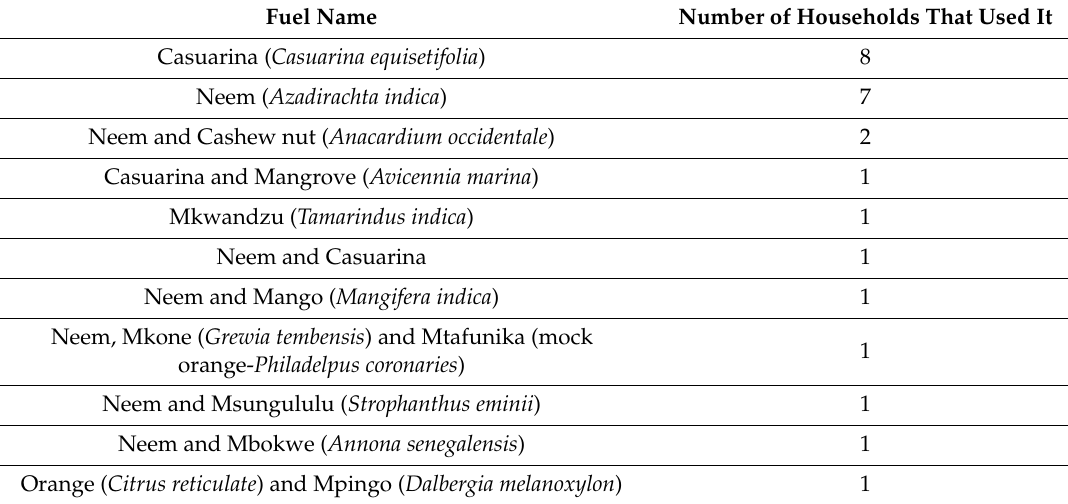
Table 1. Fuels used to cook.